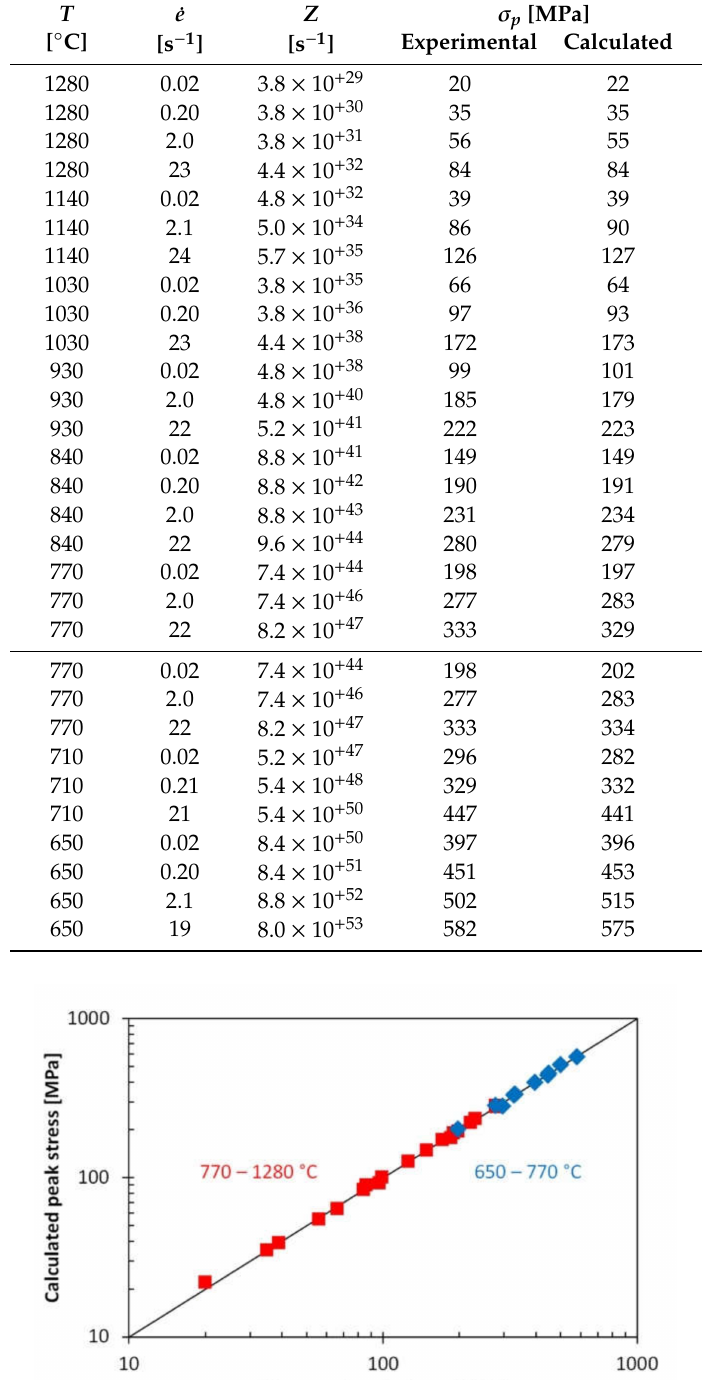
Table 1. Comparison of the measured and predicted peak stress values for the high-temperature and low-temperature regions.